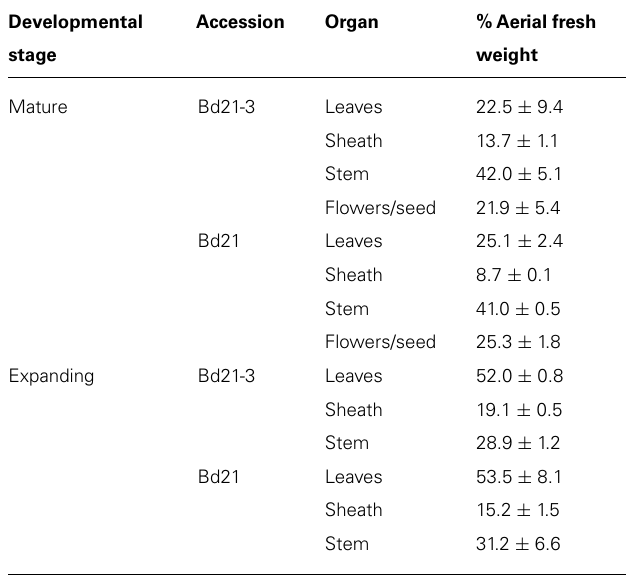
Table 6 | Relative distribution of aerial plant organs based on harvest fresh weight*.